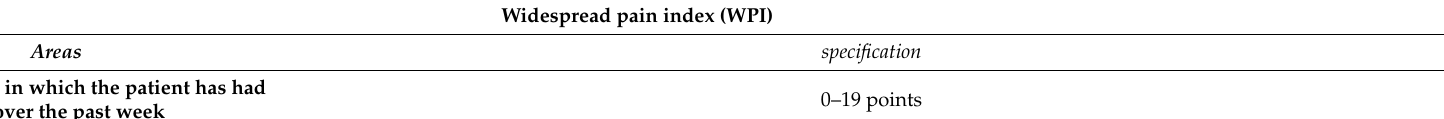
Table 1. ACR2010 and modified criteria for the diagnosis of